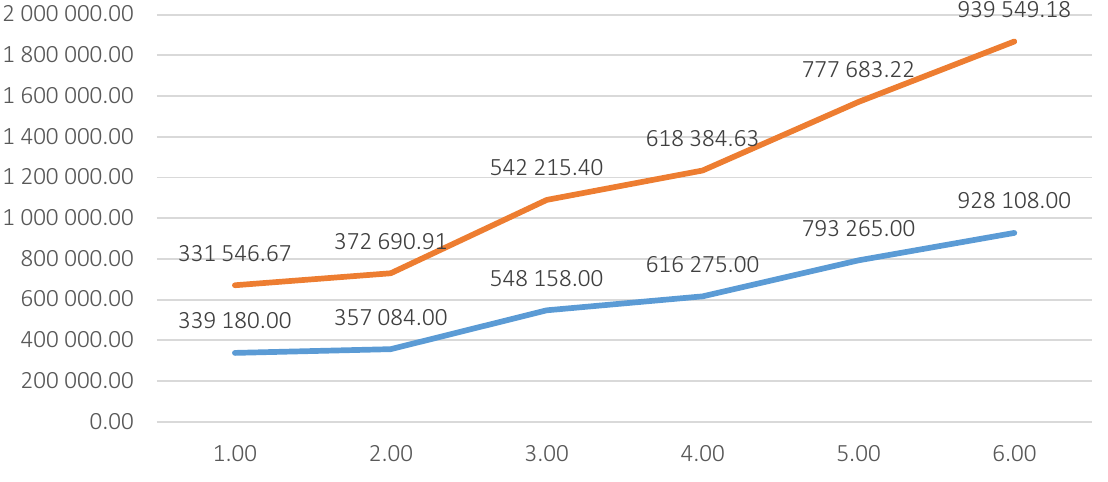
Figure 1. Graphical identification of the received forecast of state budget revenues based on the created model